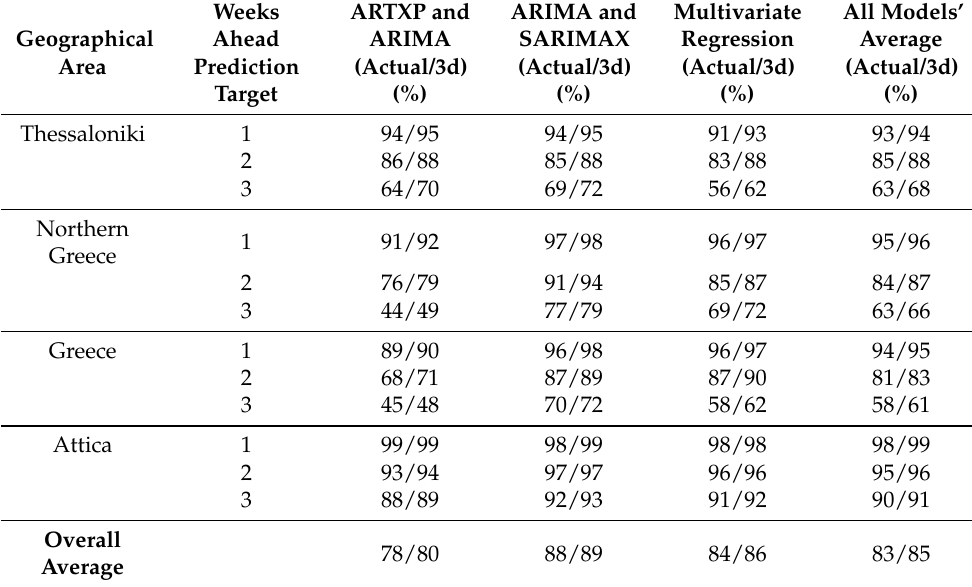
Table 4. R 2 of Predicted vs. Actual ICUs.